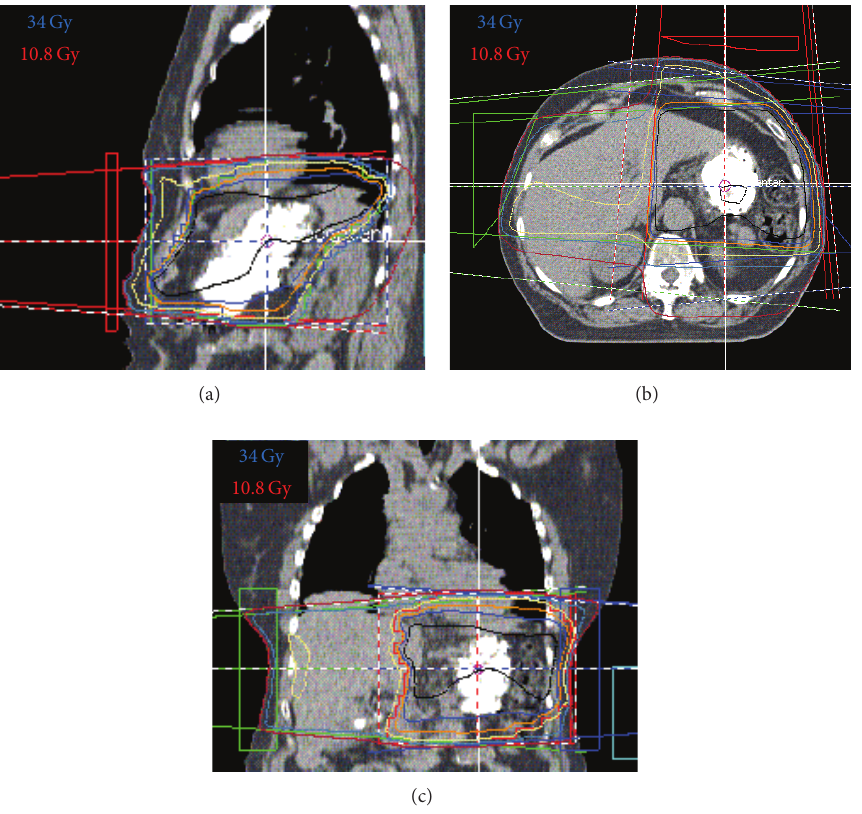
Figure 1: 3D conformal radiation therapy of MALT lymphoma of the stomach. Dose distribution in the saggital (a), axial (b), and coronal (c) planes. Black line represents the 36Gy isodose